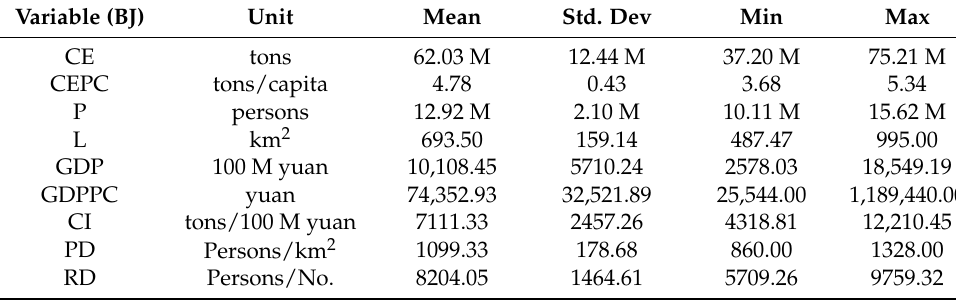
Table 3. Descriptive statistics of variables in